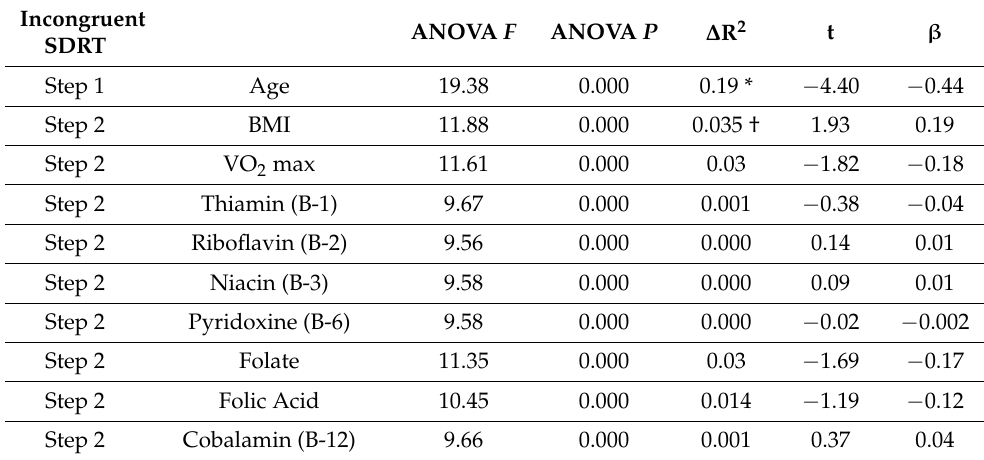
Table 8. Incongruent Standard Deviation of Reaction Time